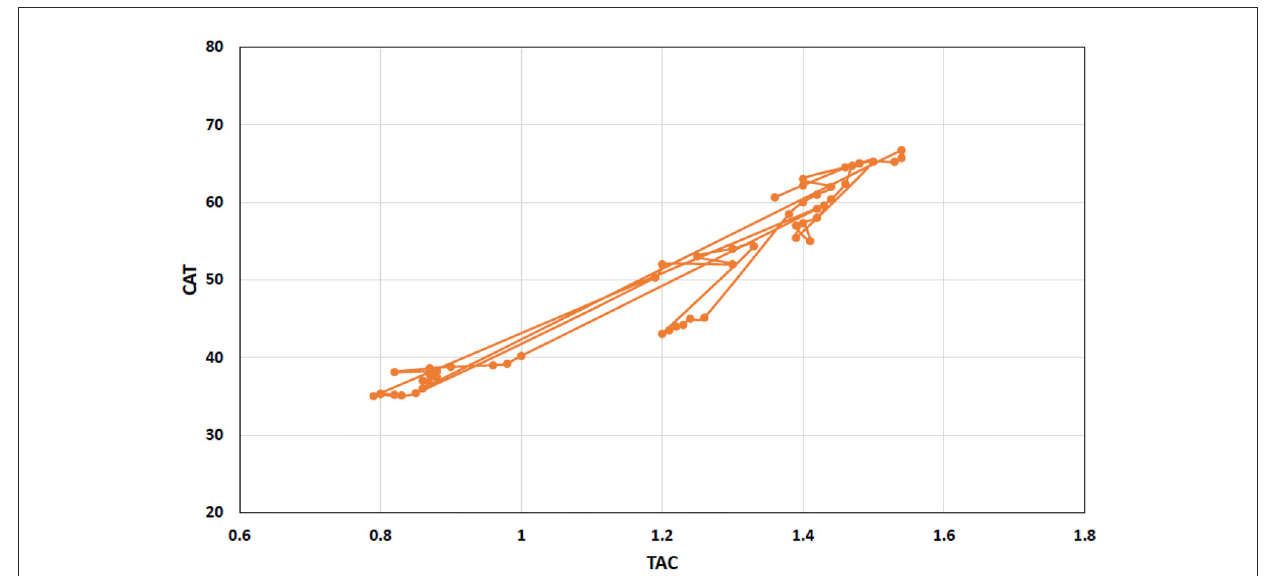
FIGURE4 Scattered and point connected graph showing total antioxidant capacity (TAC) positive Pearson correlation with catalase in broiler chicks treated with chromium, arsenic, and their combination along and amelioration with vitamin E and bentonite clay.